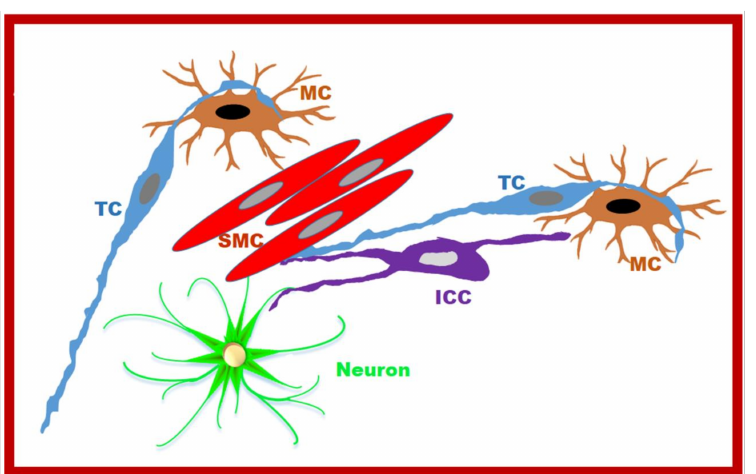
Figure 3. A schema of the complex interaction between the TCs and the MCs in the muscularis externa. On the left , an extended point of contact between a TC and an MCs is reproduced. On the right , the hypnotized TC-MCs-SMC circuit is proposed. Finally, the proposed SIP syncytium [29–31] constituted by ICC-P-SMC, where P corresponds to the PDGFR α +/TC cells, is also mimicked. The neuron makes contacts with the ICC and